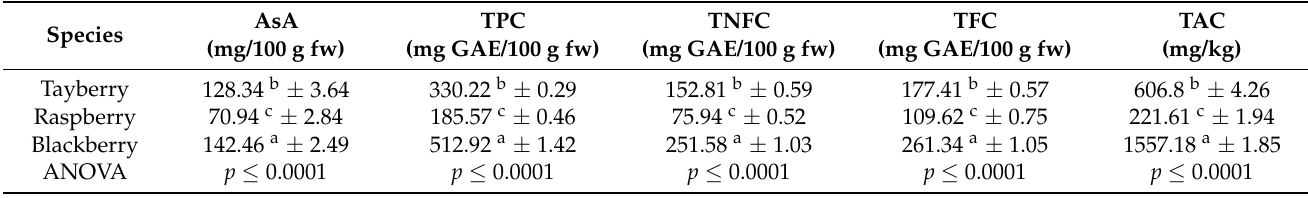
Table 4. Content of bioactive substances in fresh berry fruits.